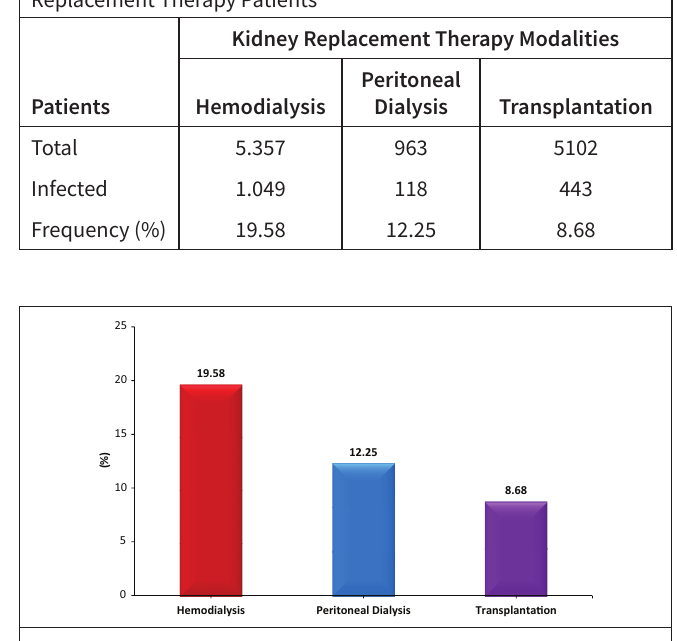
Table 1. Numbers and Frequencies of COVID-19 in Kidney